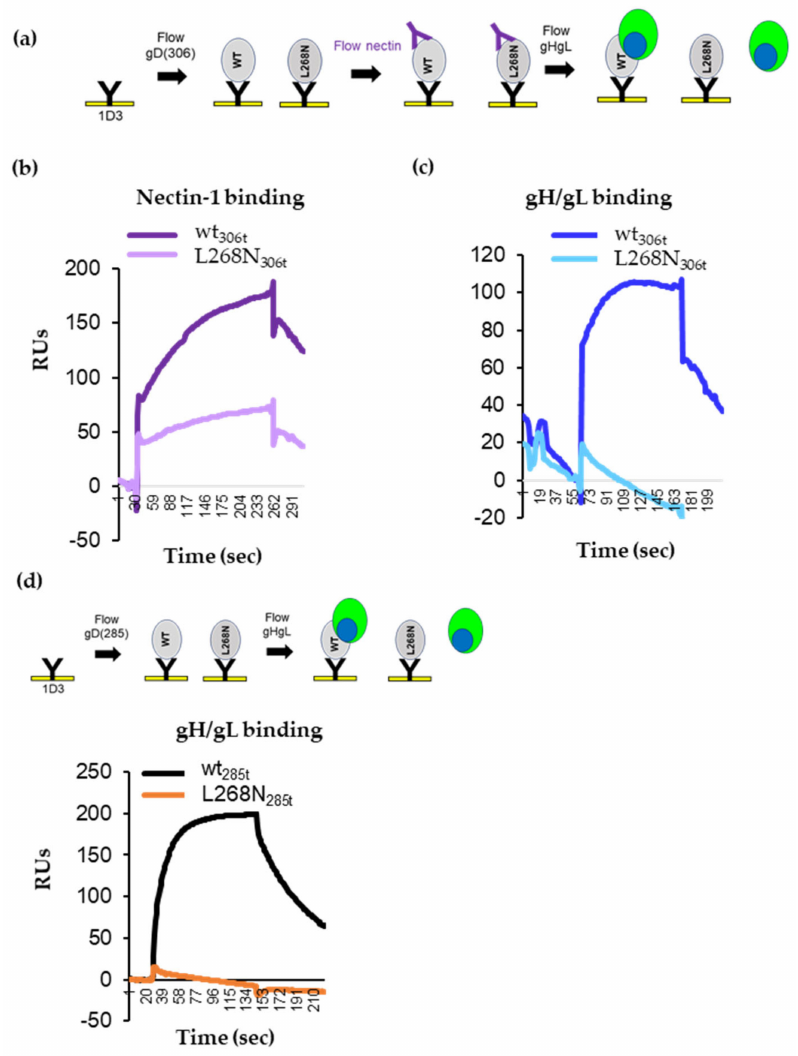
Figure 6. Ability of gD L268N to bind gH/gL. ( a ) Diagram of the Biacore 3000 protocol for analyzing the binding of gH/gL to a gD-receptor complex. gD molecules, wt, or L268N, both as 306t truncations were attached to the biosensor chip via 1D3 Mab. Sequential injection of nectin-1 followed by injection of soluble gH/gL. ( b ) Nectin-1 binds to both wt (purple) and L268N (pink) gD proteins. ( c ) gH/gL was flowed over the gD-nectin-1 complexes. gH/gL bound to wt gD (blue) but not to L268N mutant gD (cyan). ( d ) Diagram of the SPR protocol for analyzing gH/gL binding to gD 285t , wt, or the L268N mutant. Only the gH/gL binding curves are shown. gH/L binds to wt gD (black curve). No gH/gL binding was observed for the L268N mutant (orange